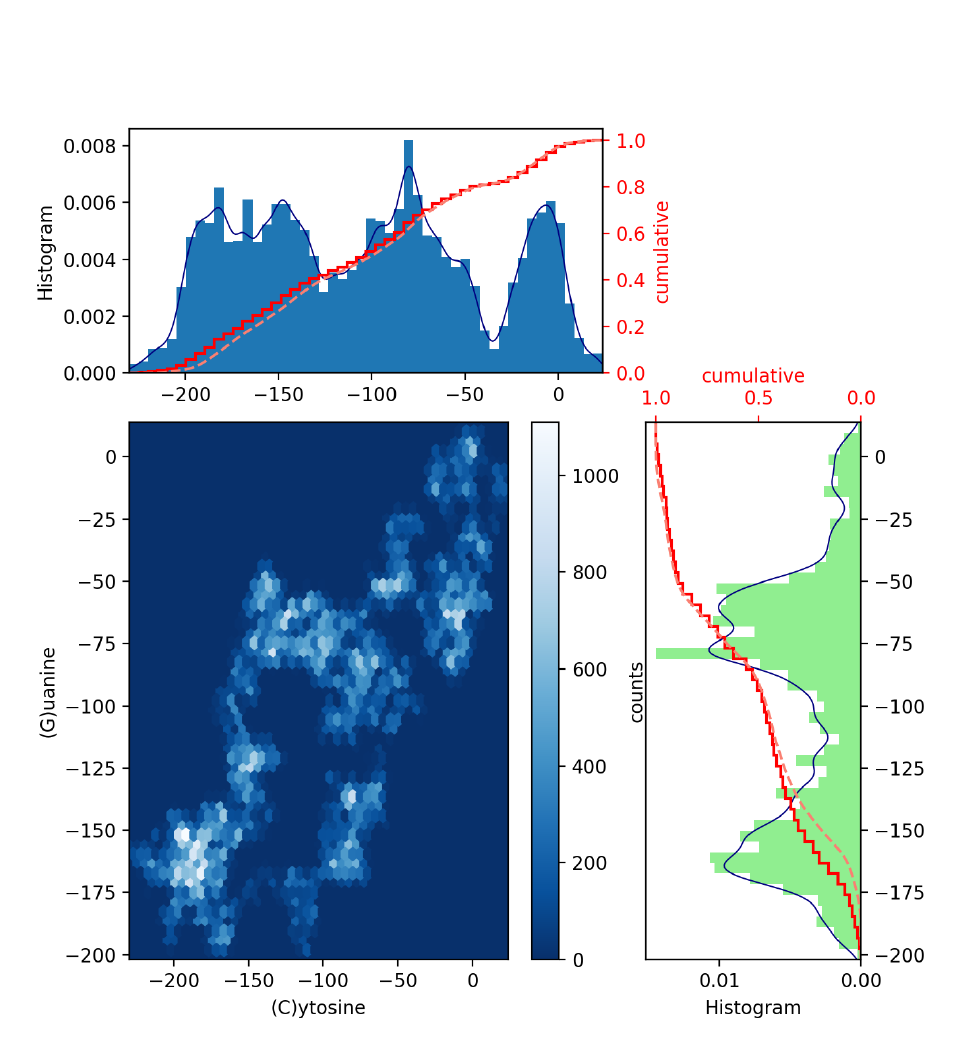
Figure 3. Scatter plot of GenomeBits (C)ytosine and (G)uanine curves with histograms for the monkeypox virus (GenBank ID